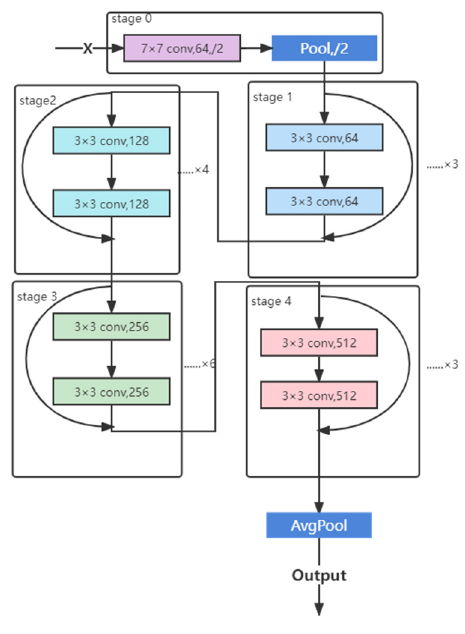
Figure 3. ResNet